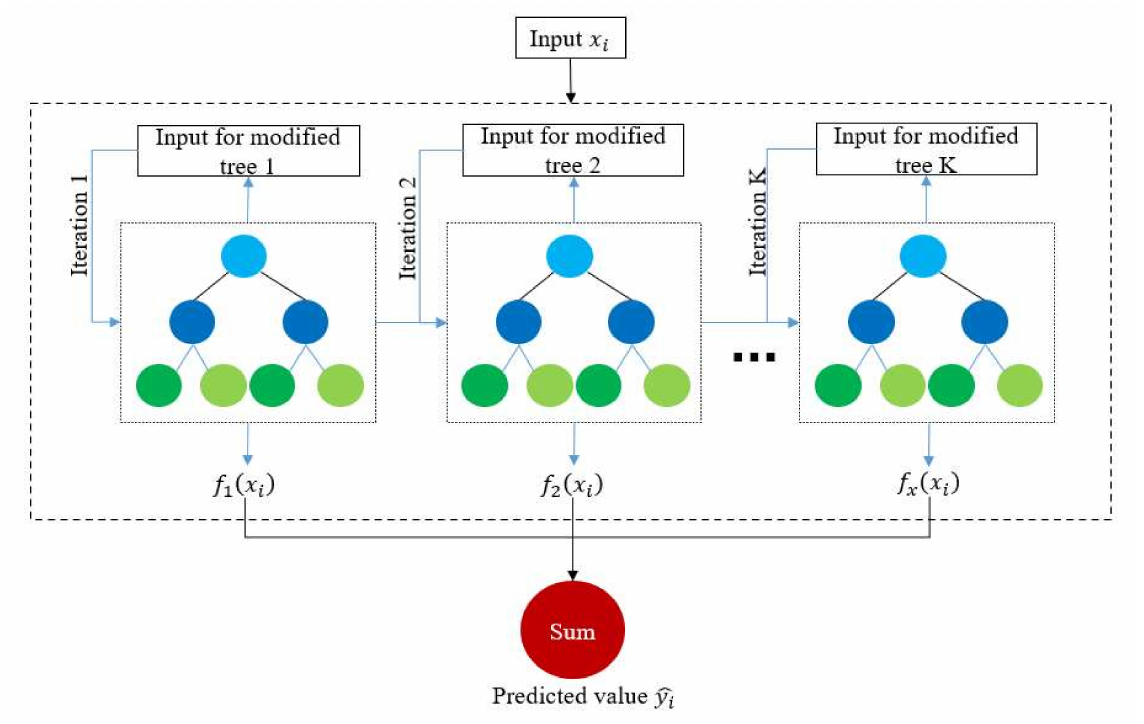
Figure 1. Schematic diagram of the XGBoost regression tree